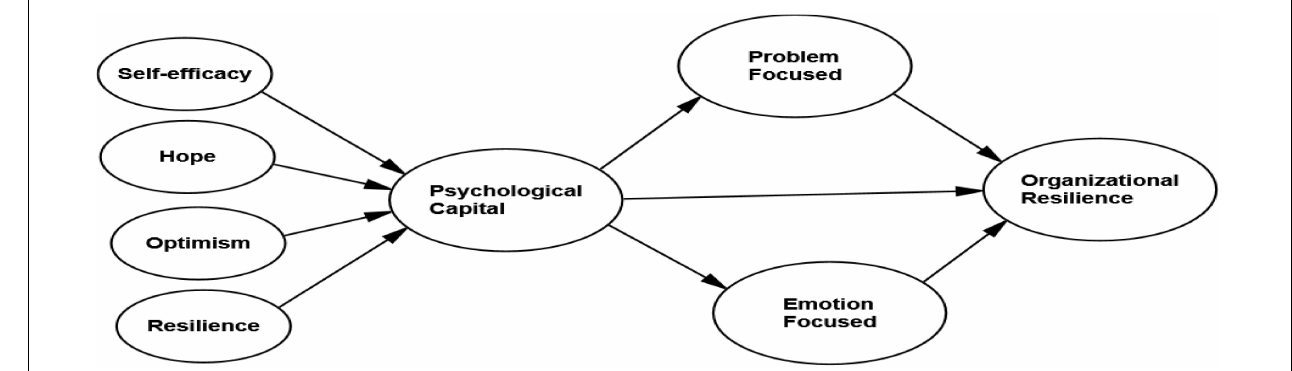
FIGURE 1 | Conceptual